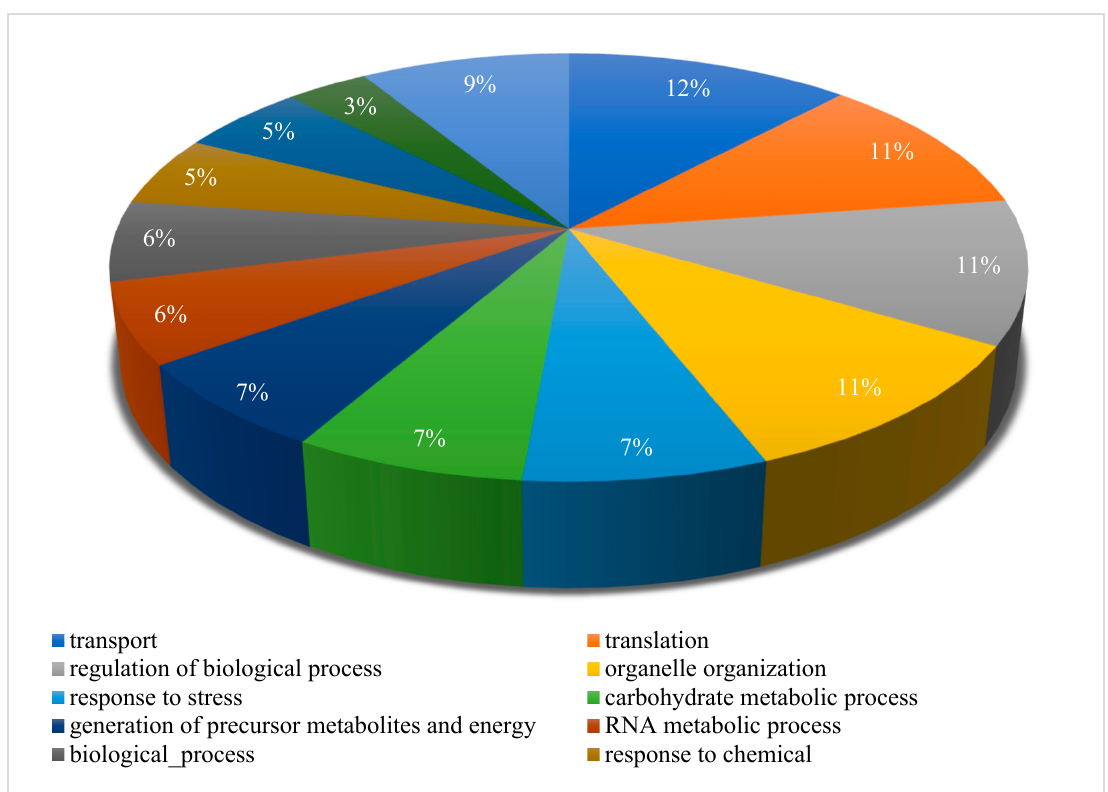
Figure 4. Pie distribution chart showing gene ontology enrichment analysis of biological processes for the proteins identified in the C. glabrata secretome. Biological processes that were common to <5% of the proteins were excluded from the chart.